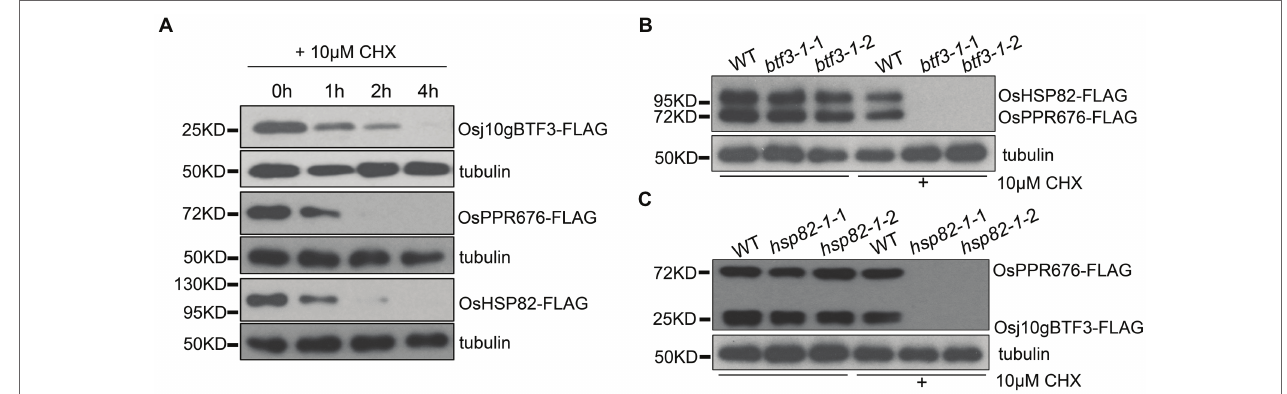
FIGURE 4 | Osj10gBTF3 and OsHSP82 protect OsPPR676 protein from degradation. (A) Osj10gBTF3, OsHSP82, and OsPPR676 extracted from protoplasts of rice seedlings were treated with cycloheximide (CHX), respectively, and the proteins were detected by FLAG antibody at different time points. Tubulin was used as an internal reference. Three independent replicates were performed for the experiment. (B) OsHSP82 and OsPPR676 were co-transfected into WT and btf3-1 mutant rice protoplasts isolated from rice seedlings, respectively. After 3 h with or without the incubation of CHX, total protein were extracted and used for Western blot. FLAG antibody was used to detect the expression of OsHSP82 and OsPPR676. btf3-1- 1 and btf3-1- 2 represent two duplicates. (C) Osj10gBTF3 and OsPPR676 were co-transfected into WT and hsp82-1 mutant rice protoplasts isolated from rice seedlings, respectively. After 3 h with or without the incubation of CHX, total protein were extracted and used for Western blot. FLAG antibody was used to detect the expression of OsHSP82 and OsPPR676. hsp82-1- 1 and hsp82-1- 2 represent two